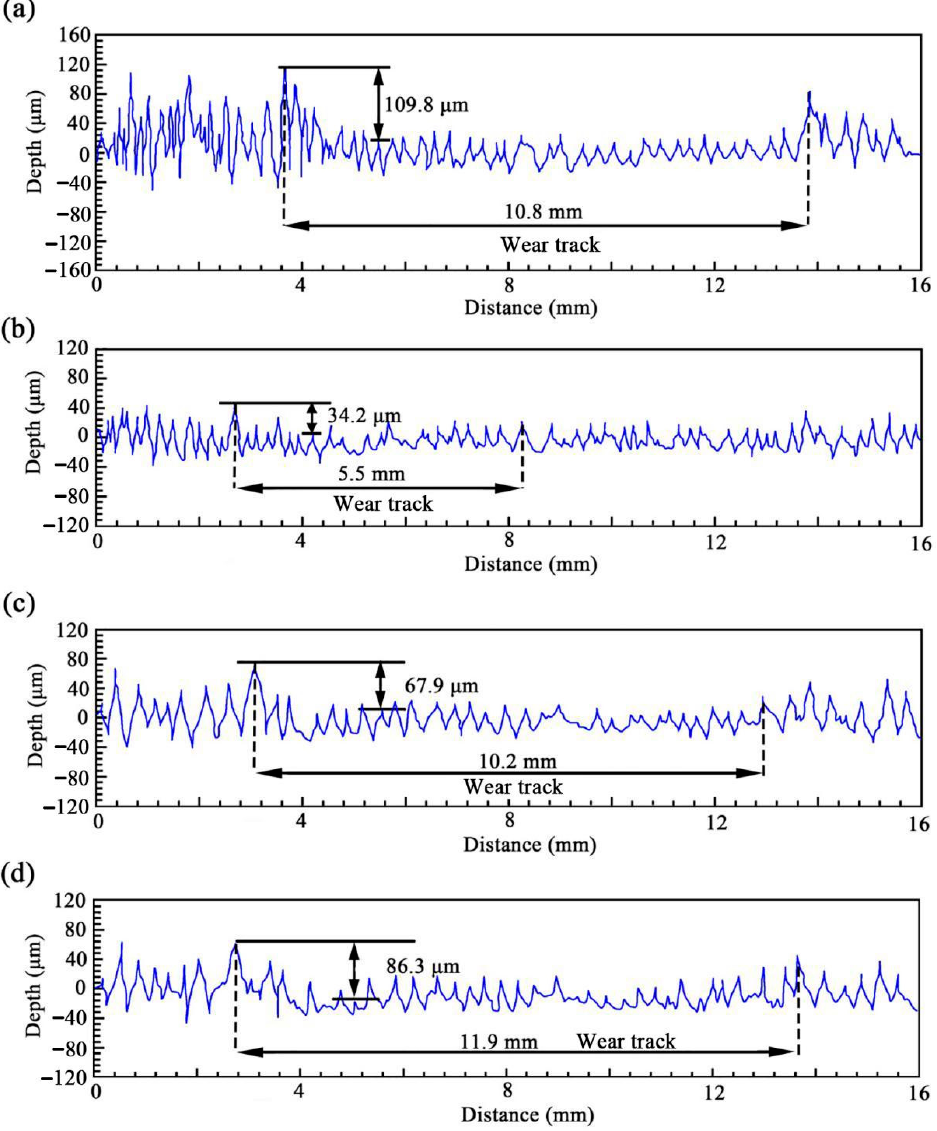
Figure 7. Wear curves of ( a ) S1, ( b ) S2, ( c ) S3, and ( d ) S4 nanocomposites.